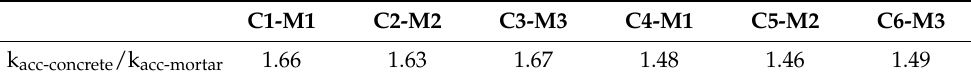
Table 18. Ratio of carbonation coefficient (k acc-concrete /k acc-mortar ) for strength classes C25/30 and C30/37 of concrete and mortar specimens exposed to accelerated carbonation.